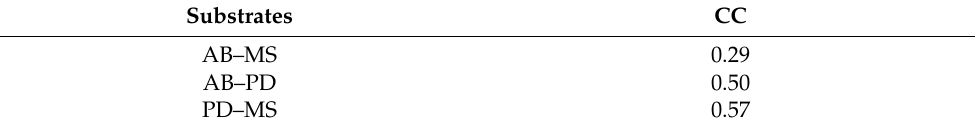
Table 4. The community coefficient (CC) of fungal taxa cultivated from different substrates.